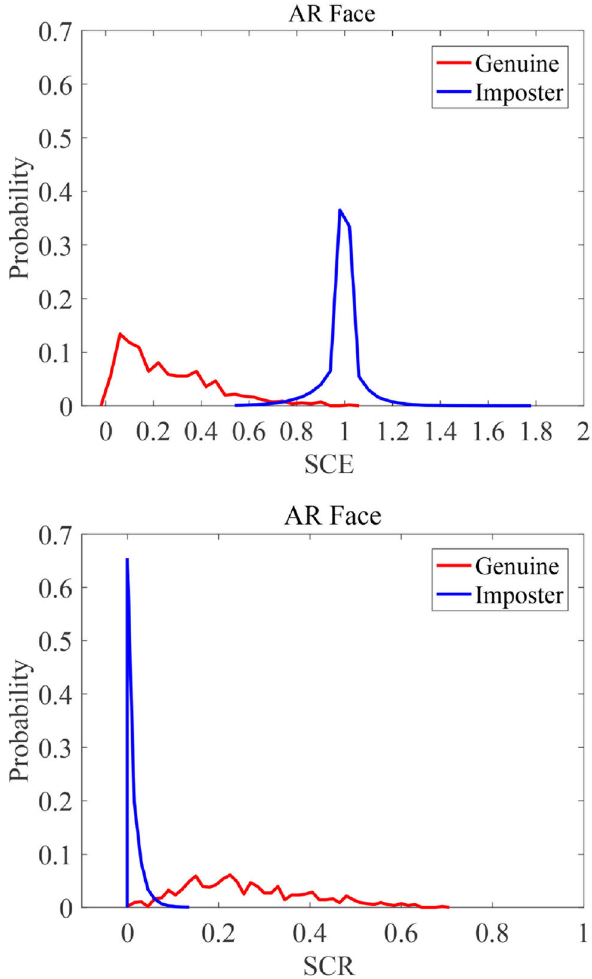
Fig. 3 Distributions of SCE and SCR scores on AR face